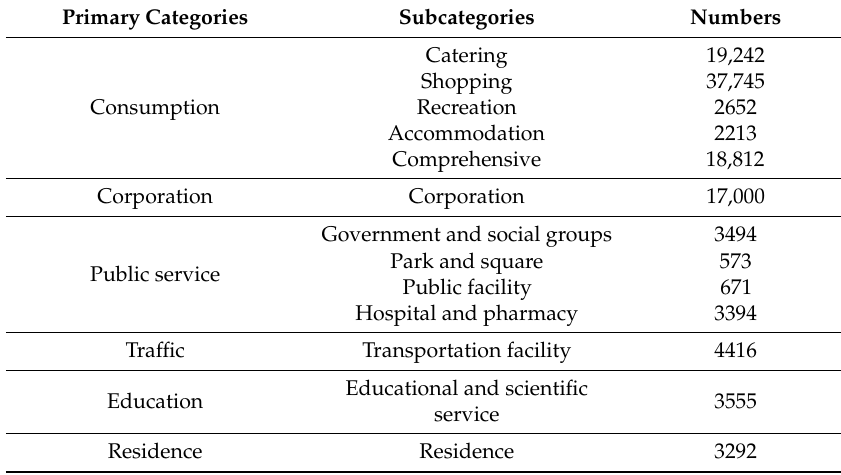
Table 1. Categories and numbers of Points of Interest